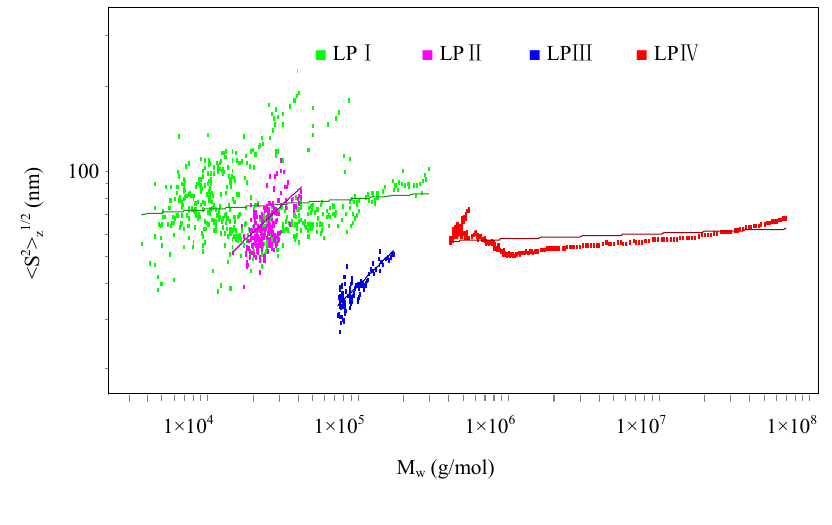
of longan polysaccharide fractions LPI–IV. w